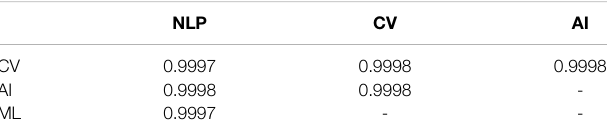
TABLE 6 | Comparison of attention maps from SciBERT models fi ne-tuned on different CS subdomains. Cosine similarity is calculated by fl attening attention maps from all layers into a single